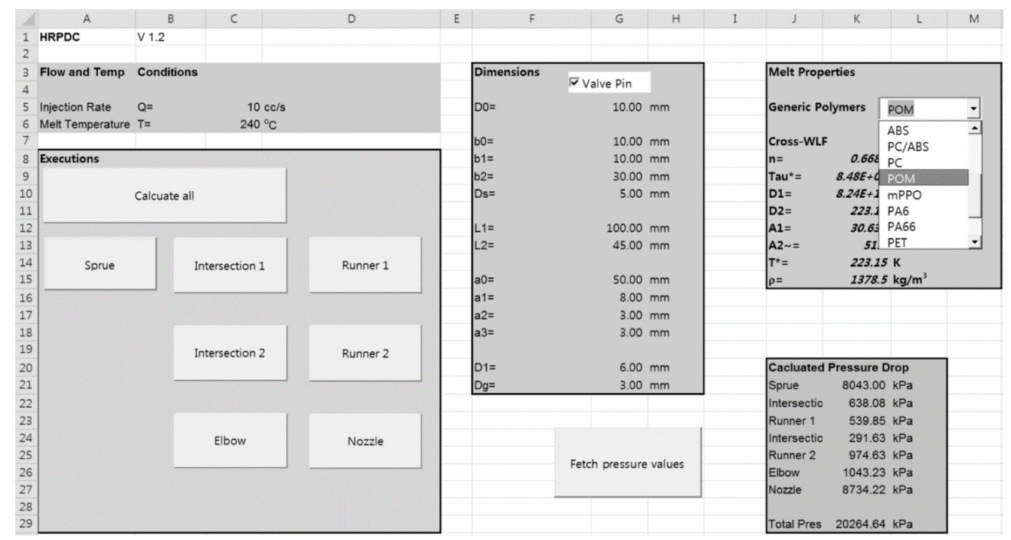
Figure 9. Hot runner pressure drop calculator (HRPDC) interface developed in an Excel sheet for execution, variable input, and material